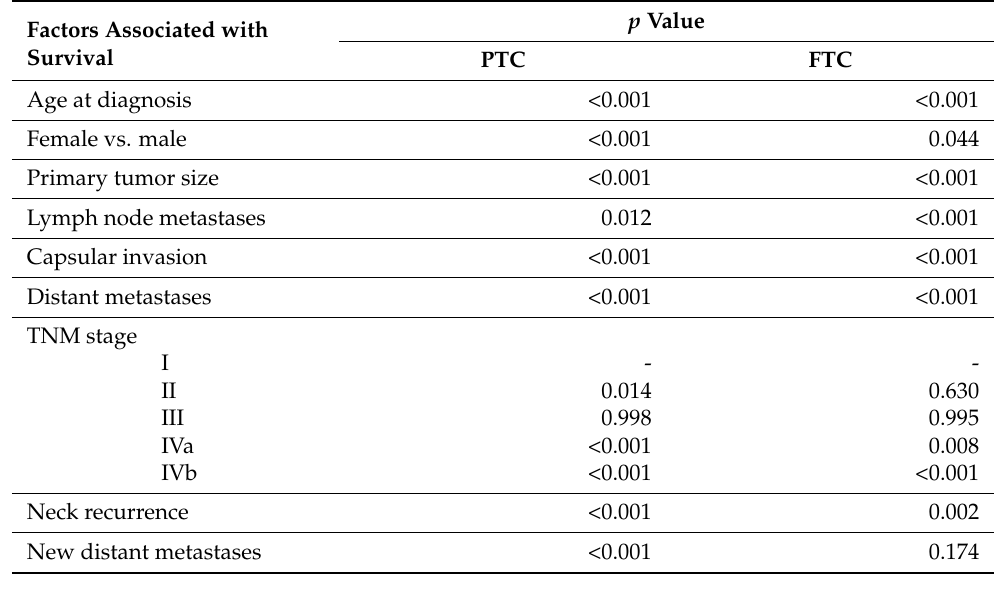
Table 3. Factors associated with survival in PTC and FTC patients by univariate analysis (Kaplan– Meier survival method, Log rank test).